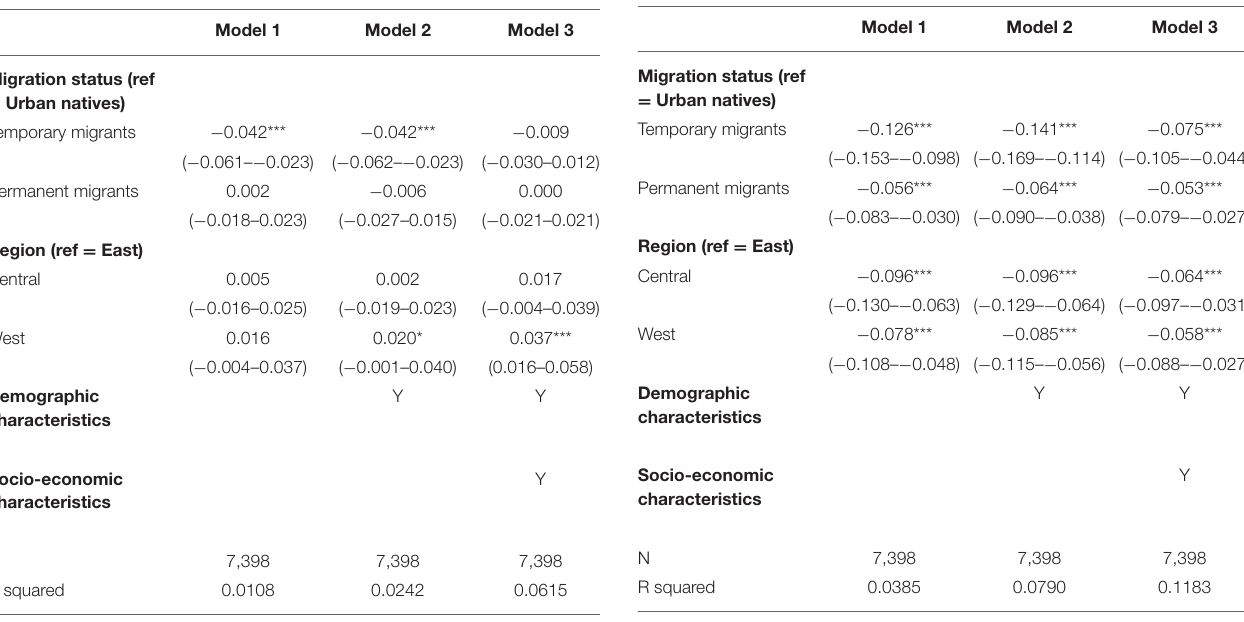
TABLE 3 | Average marginal effects of the logistic regression models predicting the commercial medical insurance enrollment